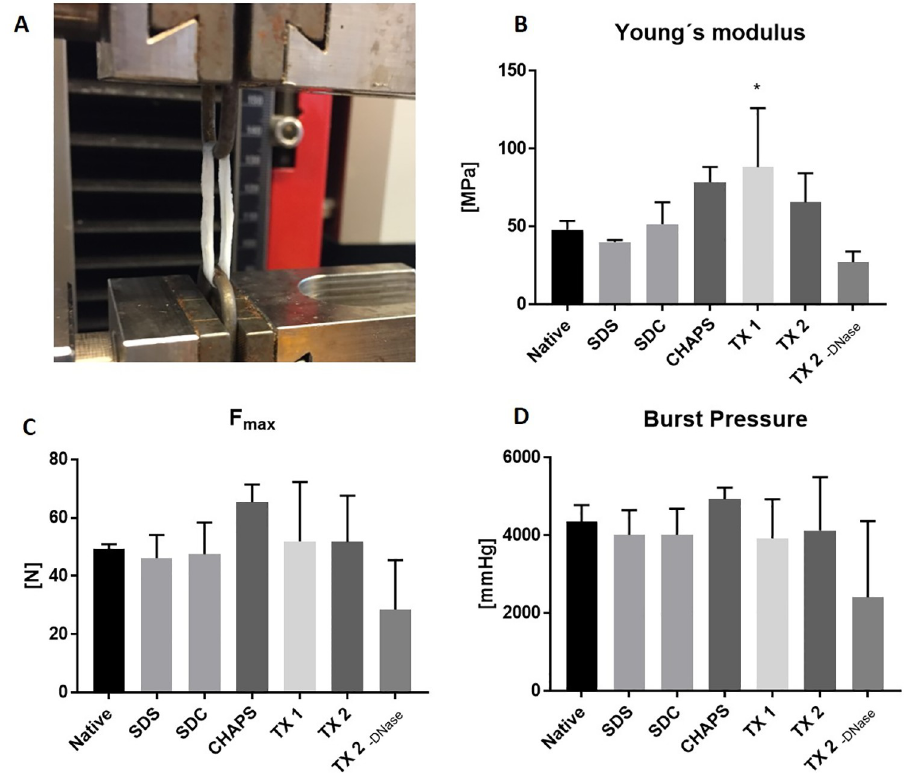
Fig 5. Mechanical testing of vein ringlets. Ringlets from decellularized and native vena cava were stretched until failure in a Zwick-Roell machine (A) Picture of testing setup with a vein ringlet clamped into the machine between 2 metal holders. (B) Measurement of material stiffness according to Young 0 s modulus. Higher values indicate increased stiffness. (C) Maximum tensile strength F max . (D) Theoretical burst pressure, calculated from Barlow’s equation (n = 3 veins, 3 ringlets from each vein as technical